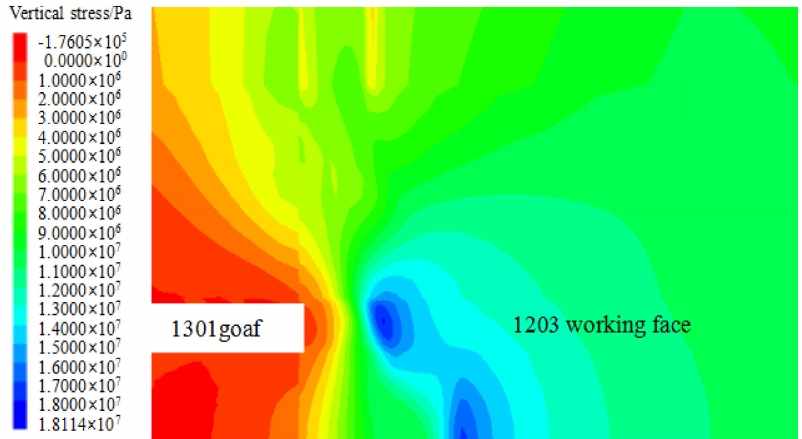
Figure 6. Vertical stress cloud diagram of the surrounding rock after mining the 1301 working face.